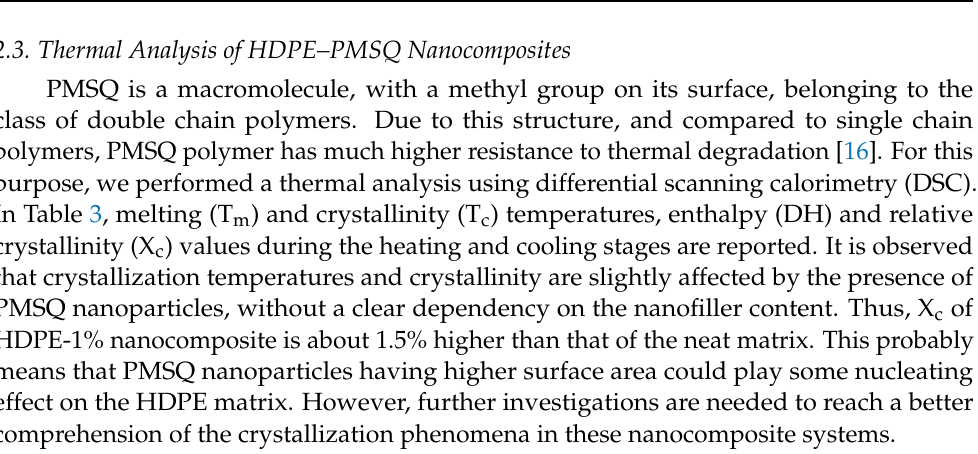
Table 3. Differential scanning calorimetry (DSC) melting temperature (T), crystallinity